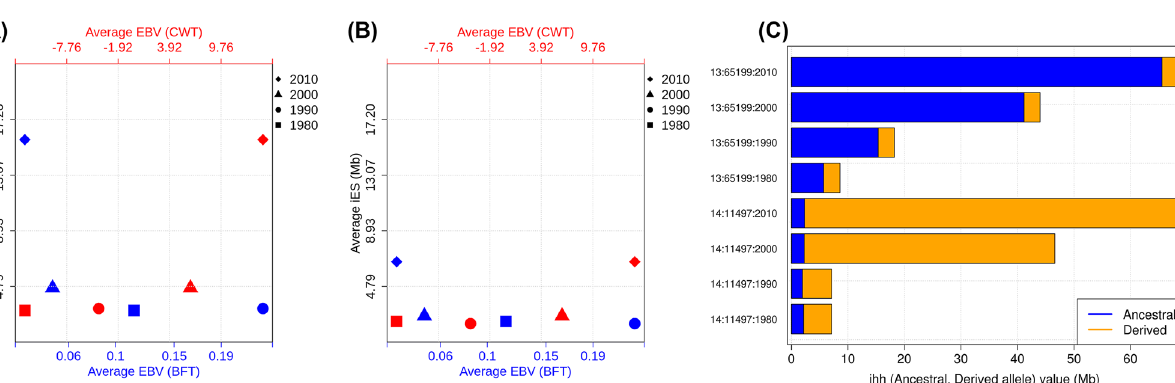
Figure 5. The estimated breeding value changes for each selected trait by decades. EBV estimated breeding value, CW carcass weight, EMA eye muscle area, BFT back fat thickness, MS marbling score.